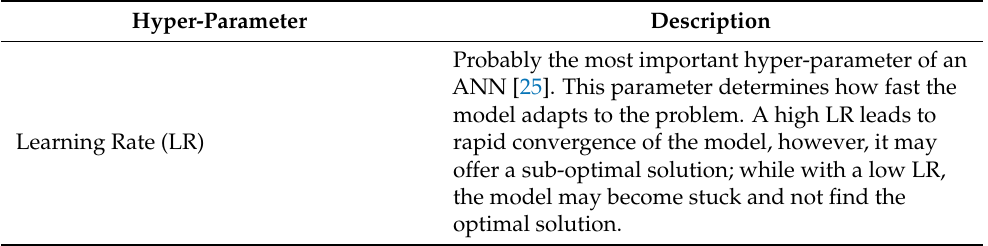
Table 1. Main hyper-parameters of artificial neural